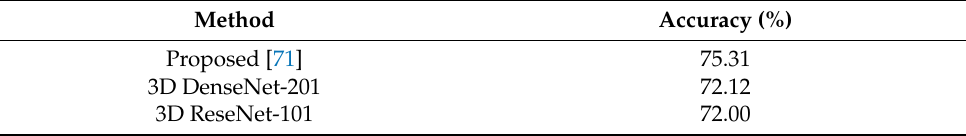
Table 2. Visual Climate Analysis subsystem: performance